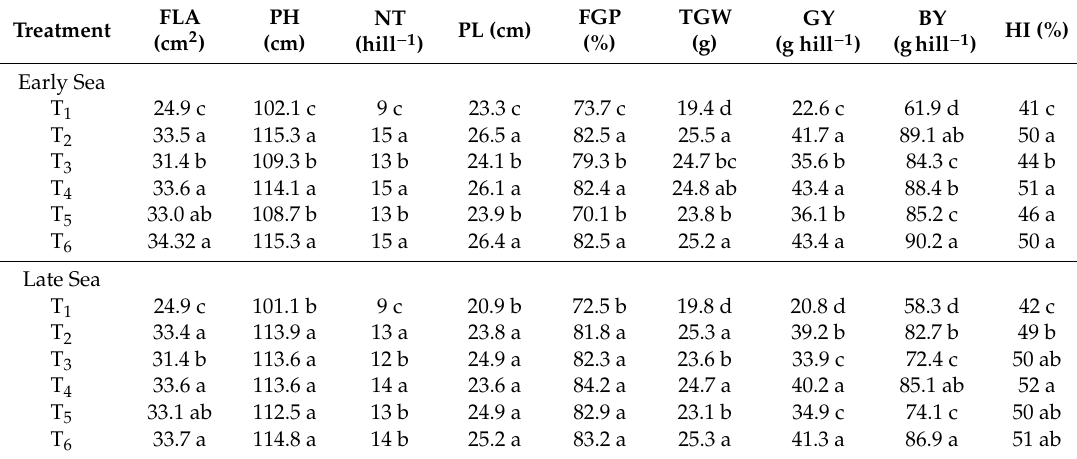
Table 7. Changes in growth, grain yield, and yield components of rice under organic and inorganic fertilizer